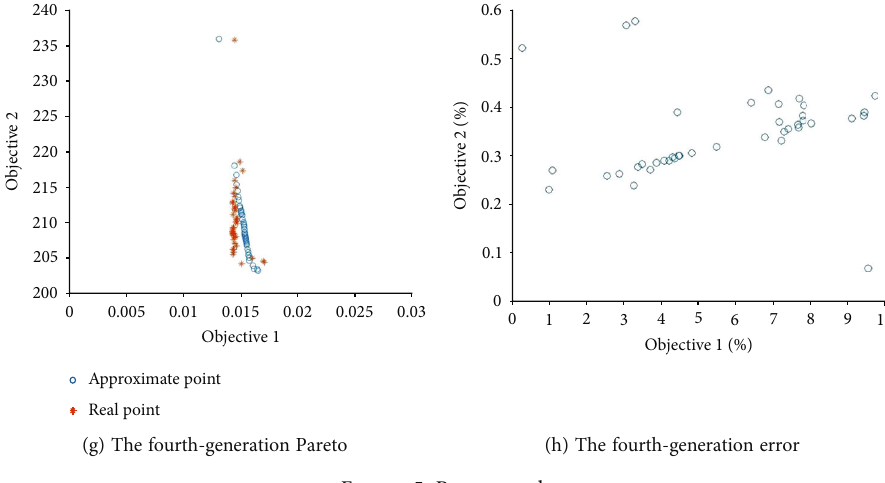
Figure 5: Pareto